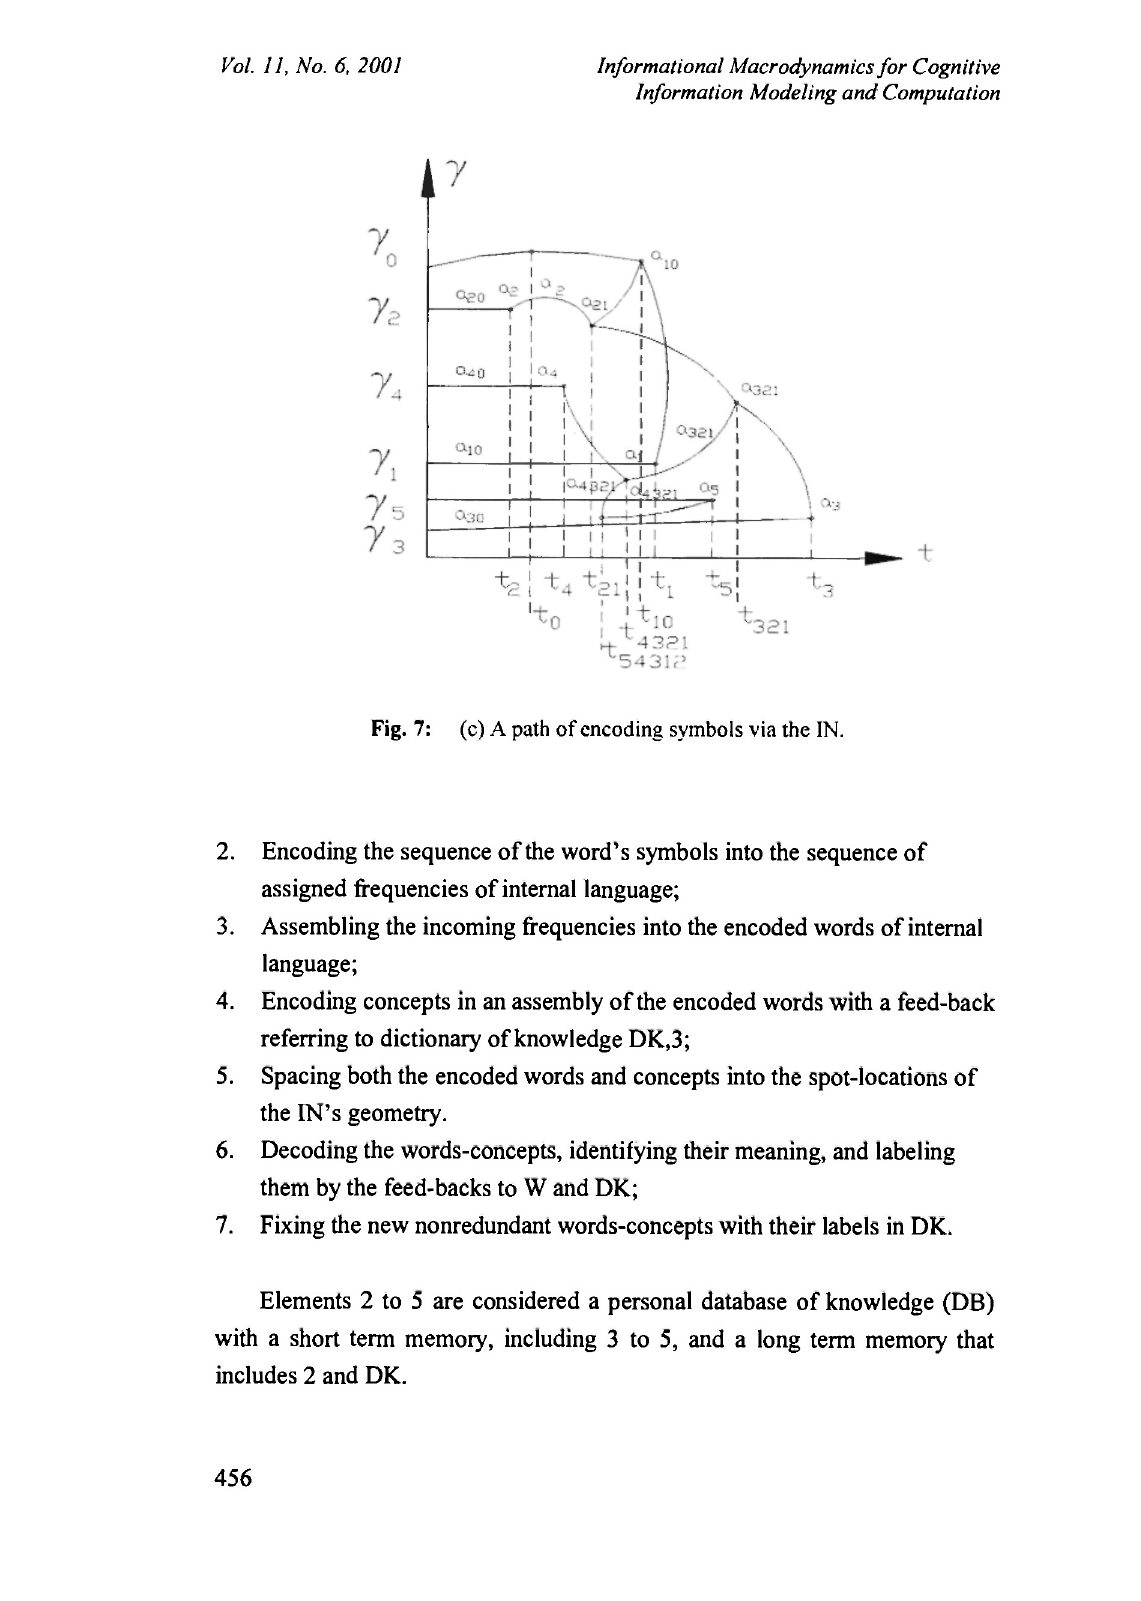
Fig. 7: (c) A path of encoding symbols via the